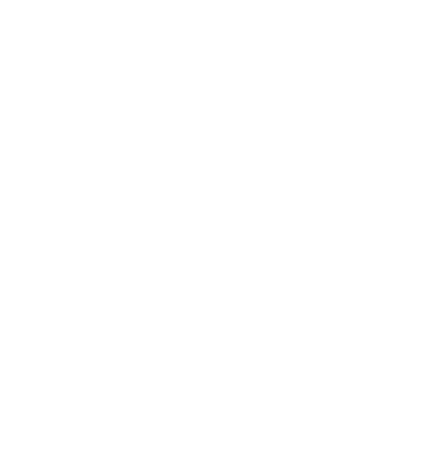
Table 1. Dataset